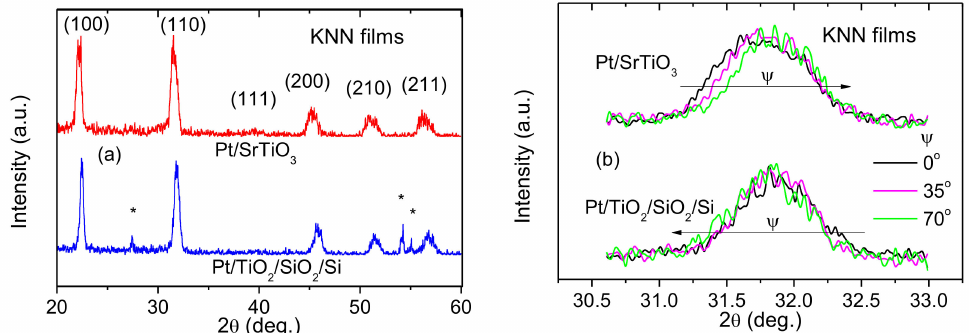
Figure 4. XRD profiles in 20 ◦ –60 ◦ 2 θ range ( a ), and around (110) peak of KNN at different tilt angles ψ used for stress calculations ( b ) of KNN films on Pt/SrTiO 3 and Pt/TiO 2 /SiO 2 /Si substrates at room temperature. Diffraction peaks of KNN phase are marked by corresponding indexes, while those from substrate are marked as * in ( a